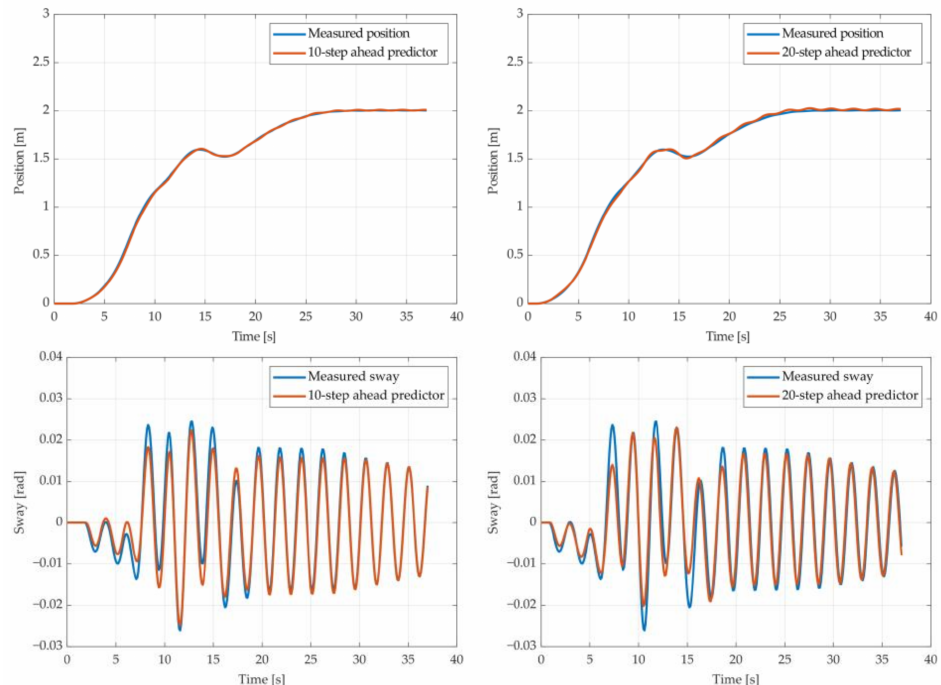
Figure 10. The 10- and 20-step ahead prediction with the ARX model of the simulated crane position and payload sway with 1.3 m rope length and 40 kg payload